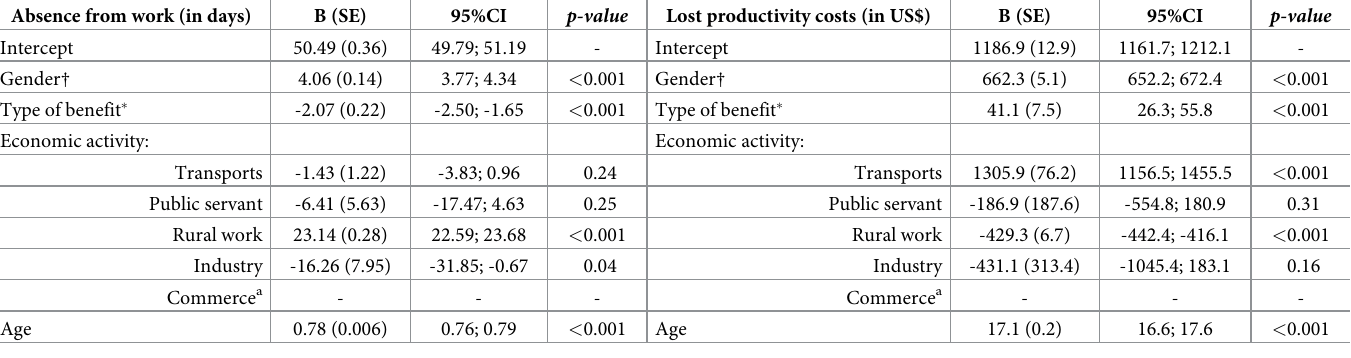
Table 4. Regression analysis on absence from work (in days), and lost productivity costs (in US$), considering the predictors gender (male; female), economic activ- ity (commerce; transports; industry; public servant; rural work), type of benefit (work-related and non-work-related sickness benefit), and age (in years; included as a